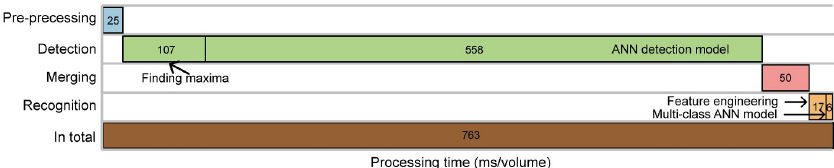
Fig 10. Speed of the CeNDeR pipeline. The processing time (ms/vol) of the entire pipeline and at each step. The detection step consists of finding local pixel intensity maxima and an ANN detection model. The recognition step contains feature engineering and a multi-class ANN model.